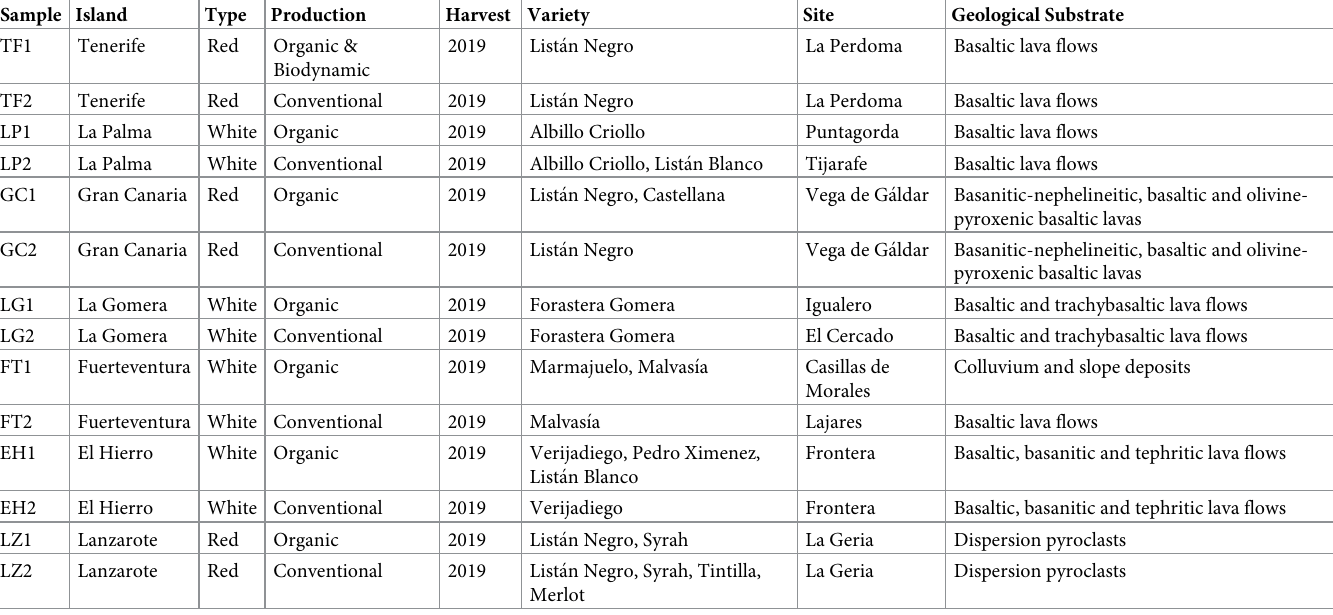
Table 1. Sample description including codification, island, type of wine, production method, harvest, grape variety, location, and geological substrate. Sample